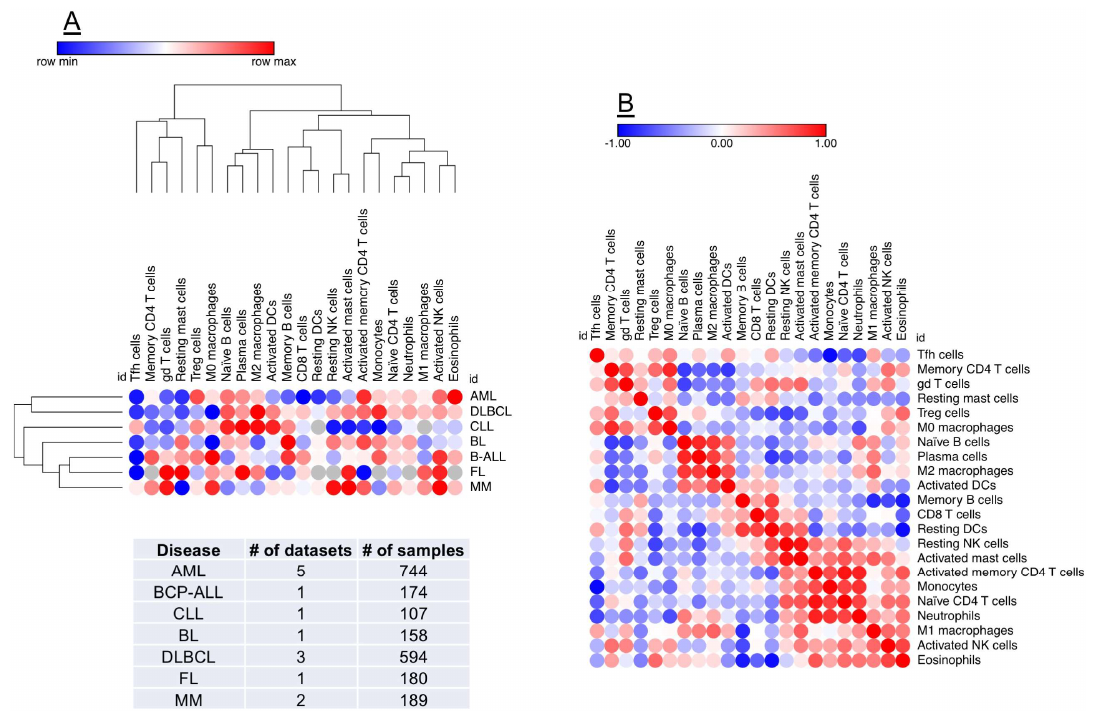
Figure 2. Identification of prognostic biomarkers in the AML TME. PREdiction of Clinical Outcomes from Genomic profiles (PRECOG) is a pan-cancer resource supporting the identification of prognostic genes in public datasets of human malignancies [104]. A machine-learning tool, known as CIBERSORT [102], can be applied to PRECOG data to comprehensively map compositional differences in tumor-infiltrating leukocytes (22 distinct subsets) in relation to patient outcome. ( Panel A ) shows hierarchical clustering (Euclidean distance; complete linkage) of CIBERSORT-inferred immune cell type fractions in a broad spectrum of hematological malignancies (1957 samples), including AML. Data were analyzed using Morpheus (Broad Institute, MA; https://software.broadinstitute.org/morpheus/). Red denotes an association with shorter survival times, whereas blue indicates an association with better clinical outcomes. Each column represents an immune cell type and each row represents a disease type. ( Panel B ) shows a similarity matrix (Pearson correlation) of CIBERSORT-inferred immune cell type fractions in hematological malignancies. This unbiased approach could support the identification of co-expression patterns of specific immune cell populations in the TME, thus providing unique insights into the immuno-biology of hematological malignancies and accelerating the delivery of personalized immunotherapy approaches. BCP-ALL = B-cell precursor acute lymphoblastic leukemia; CLL = chronic lymphocytic leukemia; BL = Burkitt lymphoma; DLBCL = diffuse large B-cell lymphoma; FL = follicular lymphoma; MM = multiple myeloma.